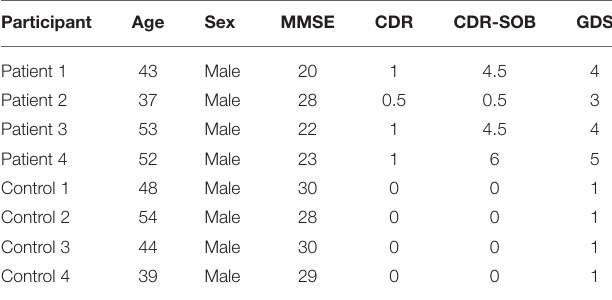
TABLE 1 | Demographic and clinical characteristics of the